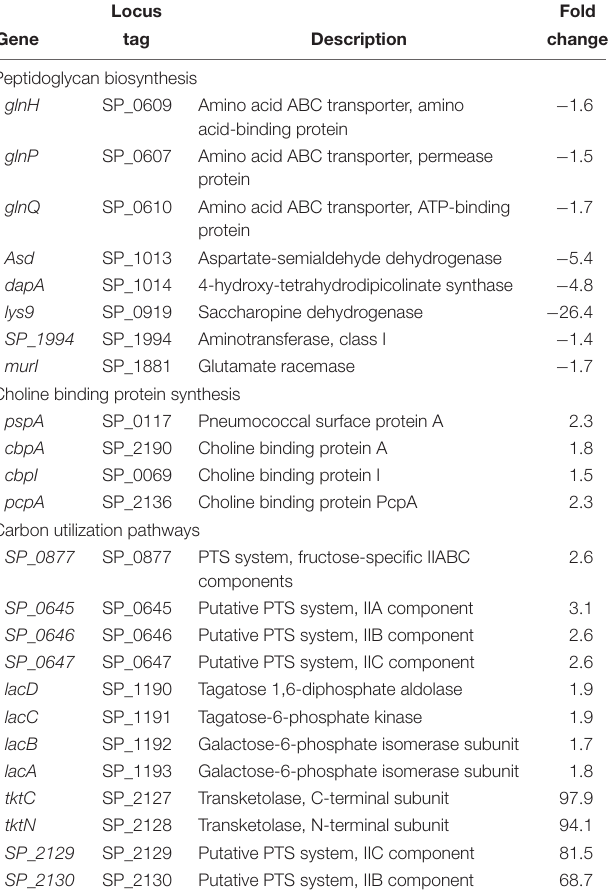
TABLE 2 | Differentially expressed genes in (cid:49) cadA involved in PG and choline binding protein synthesis, and carbon utilization pathways. Locus Fold